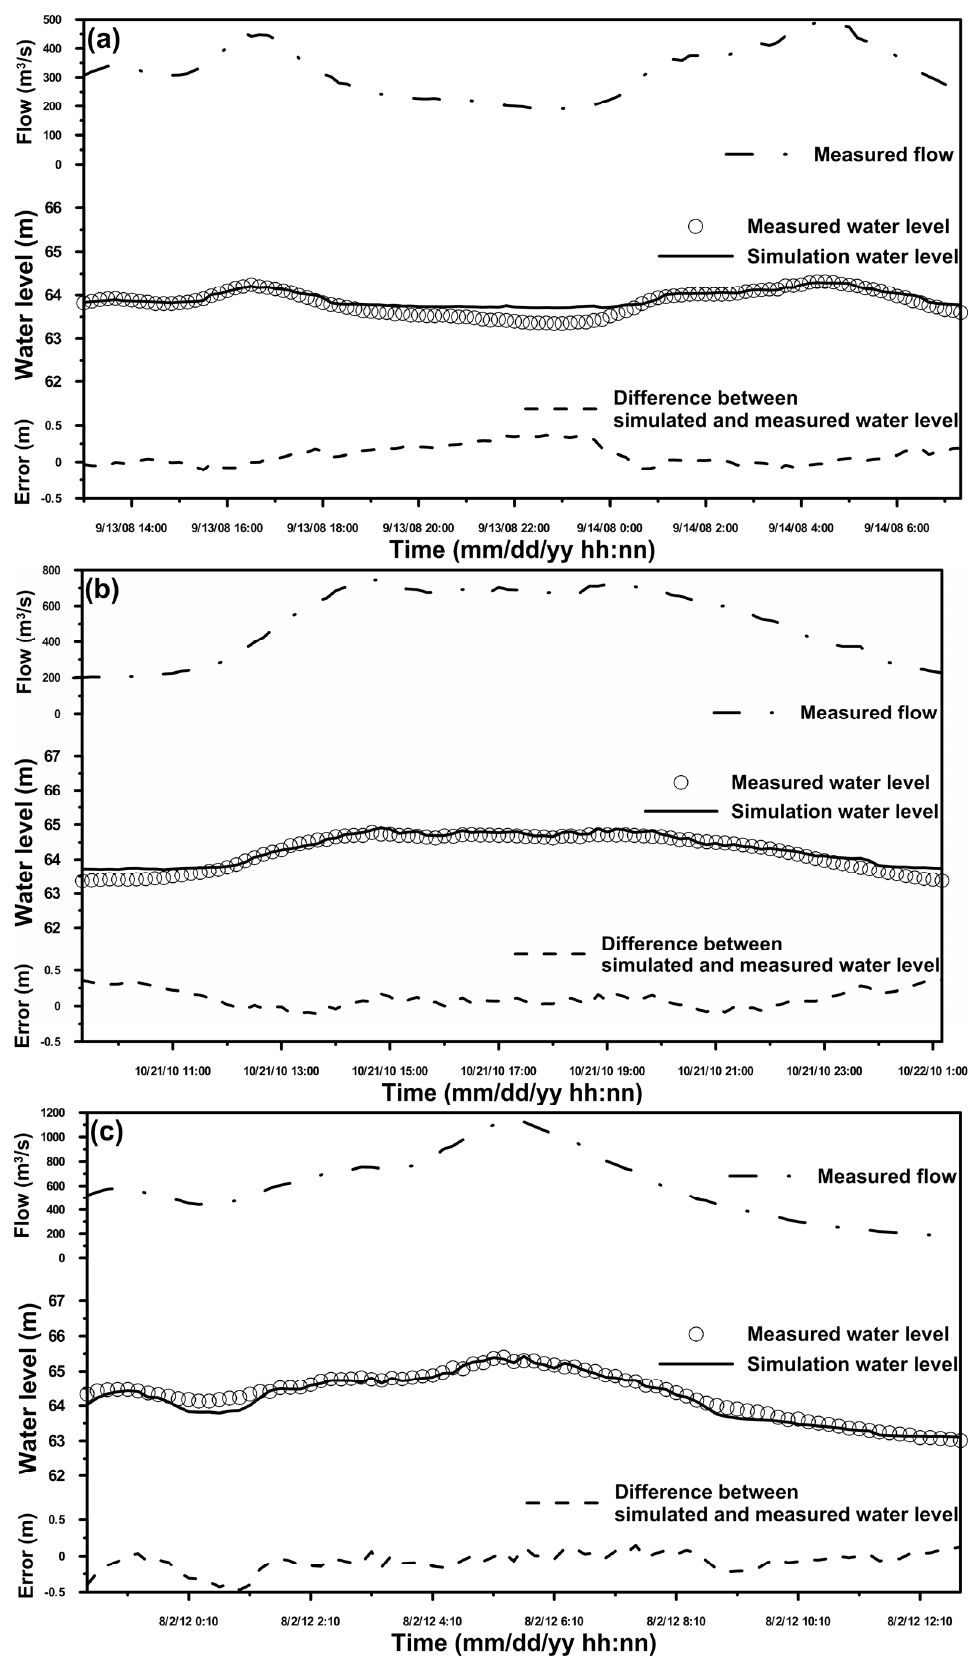
Figure 3. Model-data comparison of the water level at the Yuansantze diversion weir for ( a ) Typhoon Sinlaku (2008); ( b ) Typhoon Megi (2010); and ( c ) Typhoon Saola